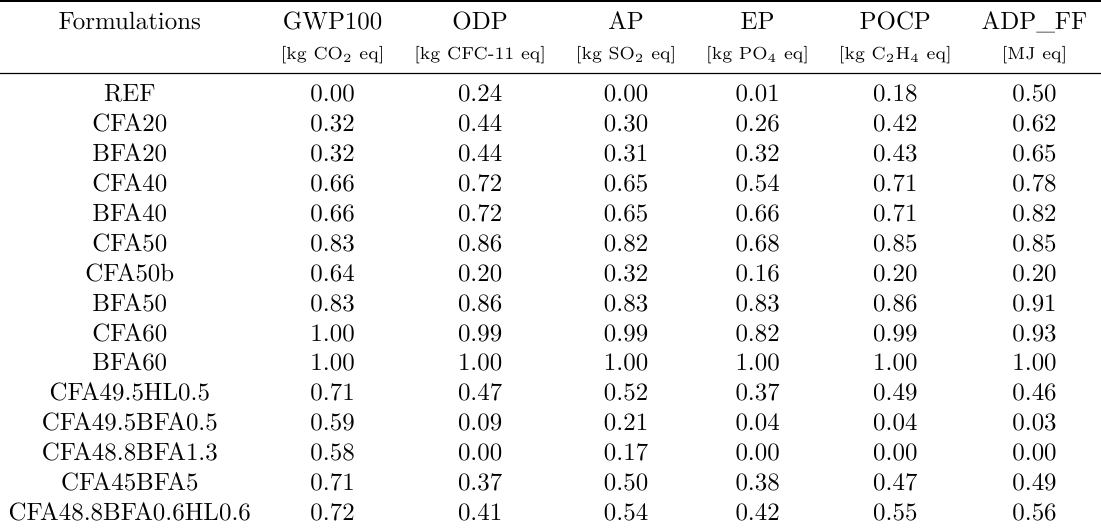
Table 5. Normalized values of the studied environmental impact categories